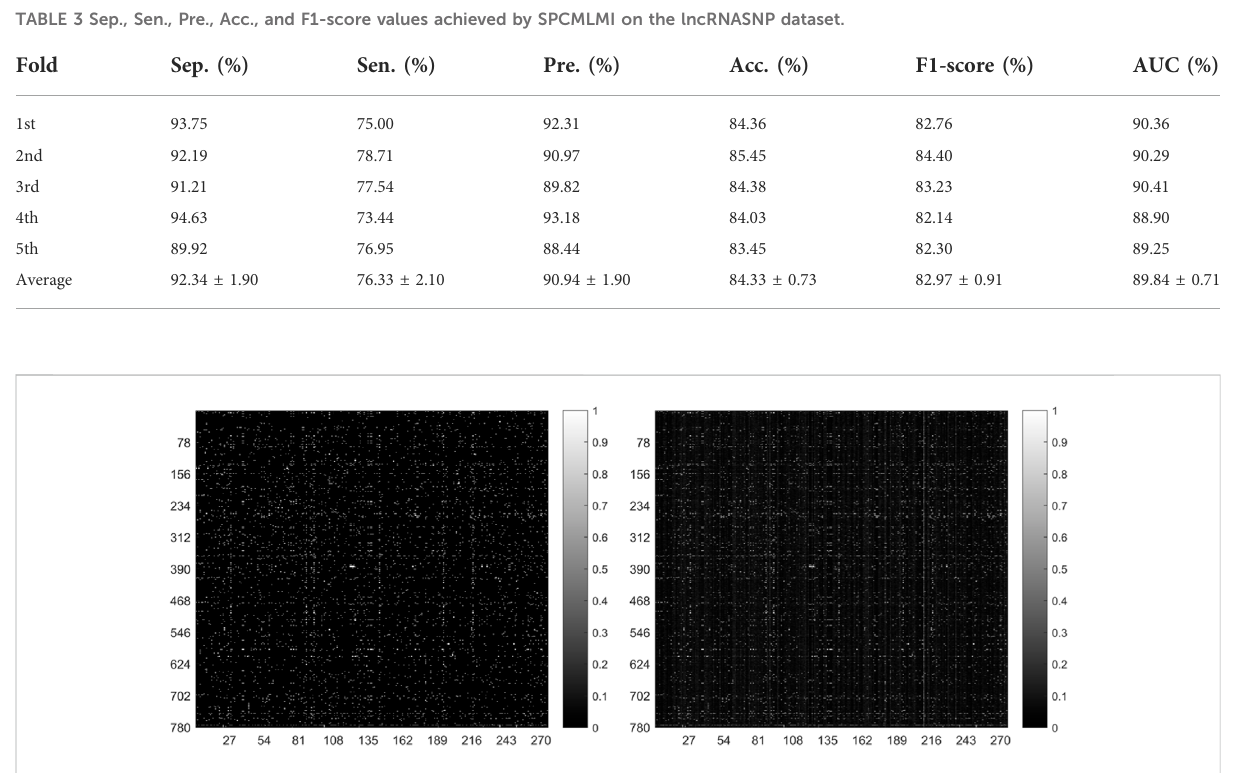
FIGURE 4 Original lncRNA – miRNA interaction adjacency matrix (left) and the result matrix (right).